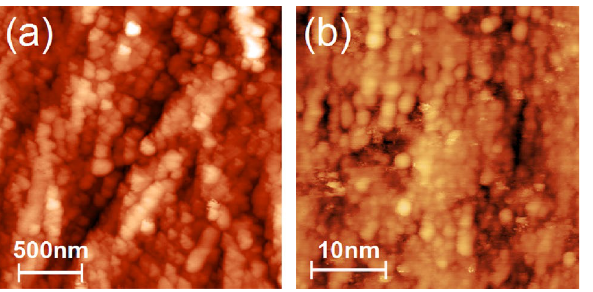
2 ) of the NiO(001) surface and ( b ) STM image (30 × 30 nm